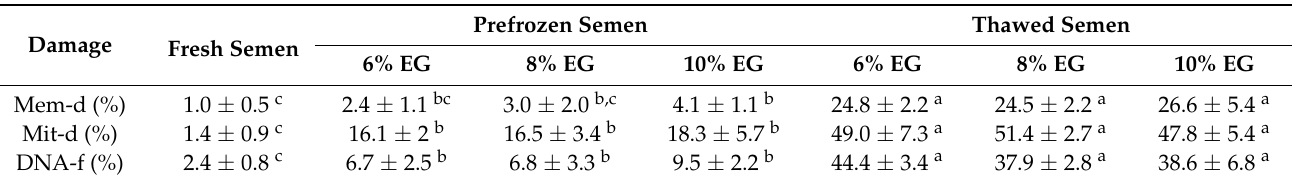
Table 2. Damages in prefrozen and frozen-thawed S. cuspicaudus sperm with different inclusion percentages (6, 8, and 10%) of ethylene glycol (EG). Different letters indicate differences ( p < 0.05). Mem-d, membrane damage; Mit-d, mitochondrial damage; DNA-f, DNA